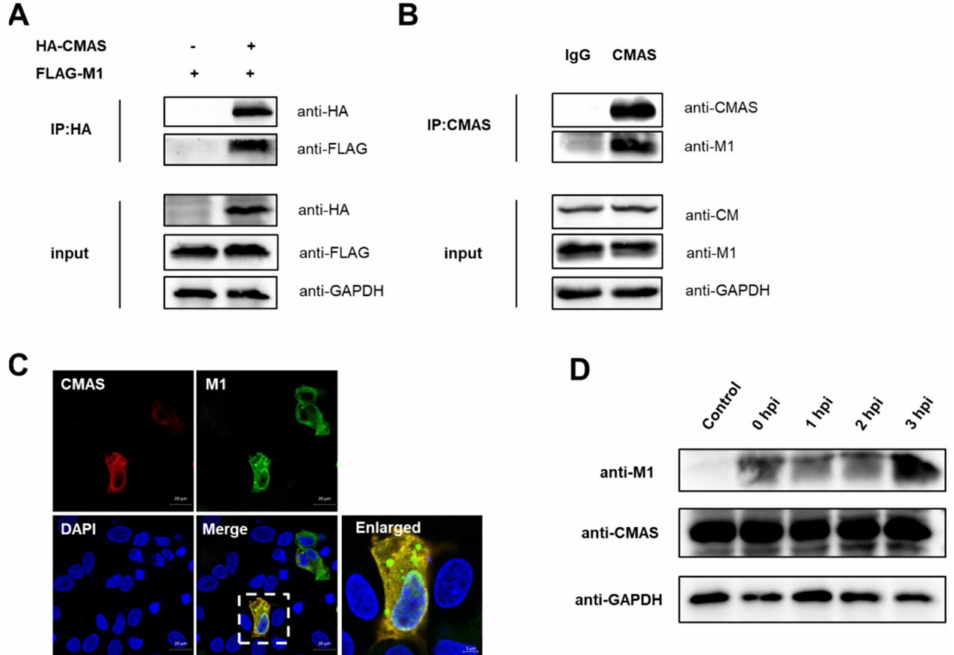
Figure 7. CMAS interacts with IAV M1. ( A , B ) Immunoblot analysis of the interactions between CMAS and M1. ( A ) HEK293T cells were transfected with HA- CMAS plasmid and Flag-M1 plasmid and followed by lysing at 24 h post-transfection. Co-IP assay was carried out using an anti-HA antibody. ( B ) The endogenous interaction between CMAS and M1. WT NPTr cells were infected with Sw/HuB/H1N1 strain and followed by lysing at 24 hpi. Immunoblot analysis was performed by using an anti- CMAS rabbit antibody or rabbit IgG. ( C ) Colocalization of CMAS and M1. WT NPTr cells were transfected with HA- CMAS and plasmid Flag-M1 plasmid then fixed at 24 h post-transfection. Colocalization of CMAS and M1 was analyzed by confocal microscopy. Scale bar = 20 µ m. ( D ) WT NPTr cells were infected or not infected with Sw/HuB/H1N1 strain, and placed on ice for 1 h for IAVs adsorption to ensure that the life process of each group of IAVs was consistent. The cell lysates were collected at the designated time point for Western blot